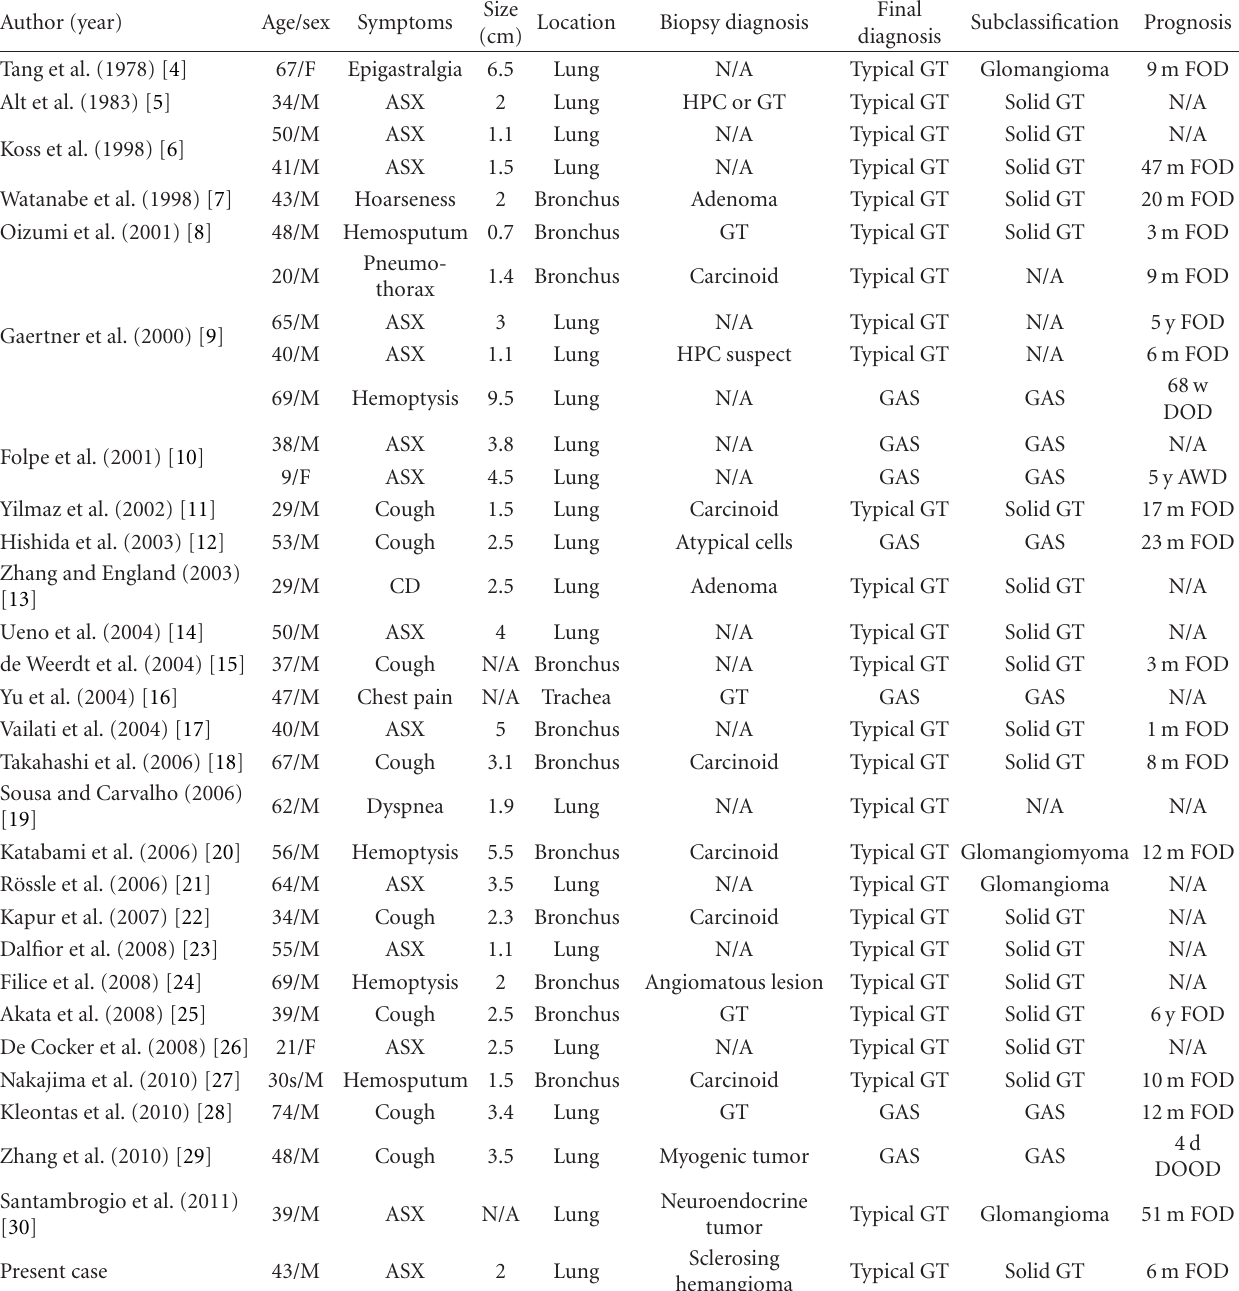
Table 1: Clinopathological features of glomus tumor in the respiratory